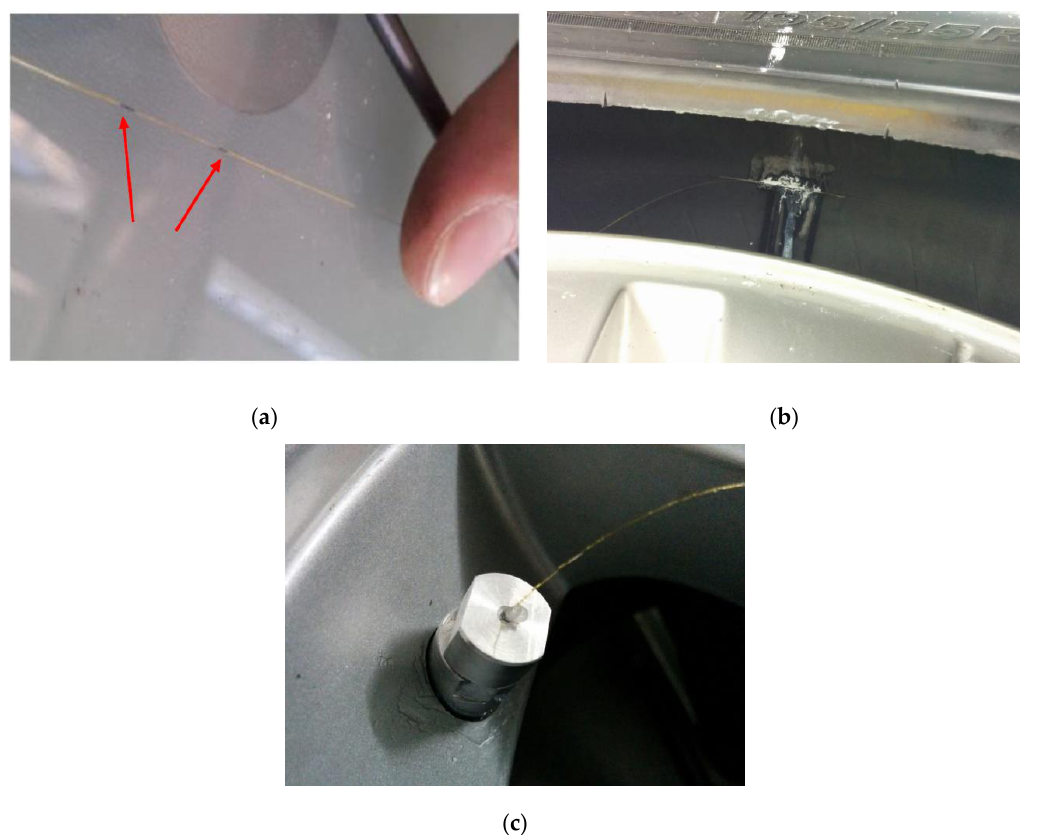
Figure 1. ( a ) The optical fibre with one fibre Bragg grating (FBG), the sensor lies within the black marks on the line; ( b ) the optical fibre pasted into the inner liner of the tyre; ( c ) the fibre exit connector from the rim.